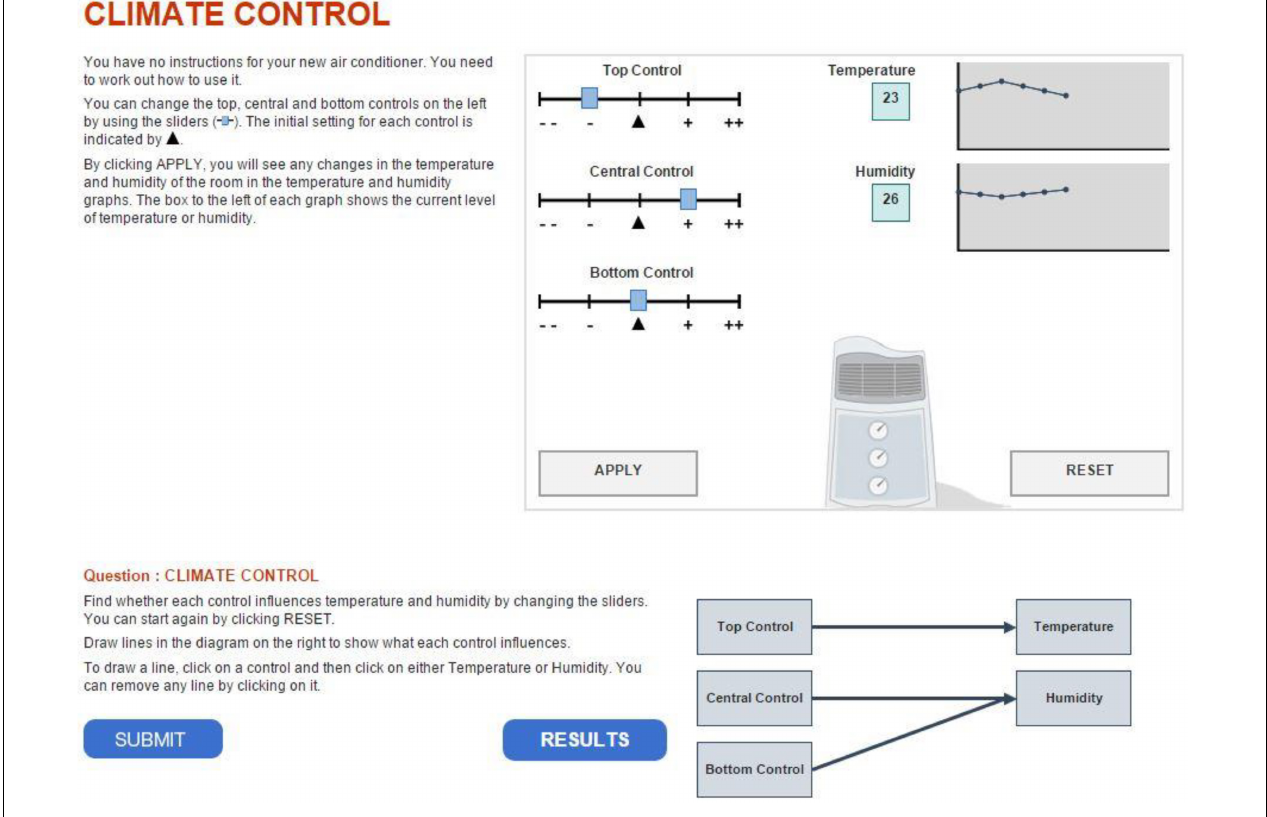
FIGURE 1 | A snapshot of the problem-solving item Climate Control in PISA 2012.